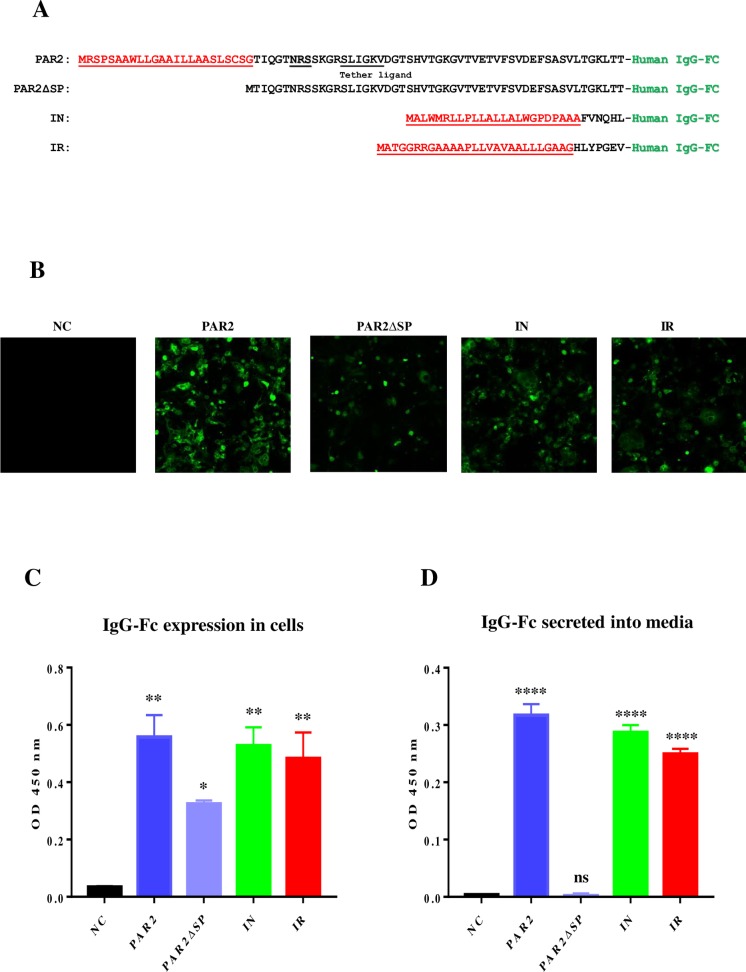
PAR2 signal peptide behaves like a classical signal peptide.A. Expression constructs for testing the role of the signal peptide of PAR2 in leading IgG-Fc secretion. The N-terminus of PAR2 with its signal peptide (PAR2), the N-terminus of PAR2 without the signal peptide (PAR2ΔSP), the N-terminus of insulin (IN), and the N-terminus of insulin receptor (IR) are fused to the human IgG-Fc fragment respectively. The signal peptide regions of PAR2, insulin, and insulin receptor are highlighted in red and underlined. Human IgG-Fc fragment is highlighted in green. B, C. Detection of IgG-Fc expression in cells by immuno-fluorescent staining and ELISA. COS7 cells expressing various IgG-Fc fusion proteins as indicated were fixed, penetrated using detergent, and then stained by FTIC-labeled fluorescent antibodies (B) or detected by ELISA (C). For ELISA, samples are performed in quadruplicates and the results are shown in mean ± sd. Statistical analysis (One-Way ANOVA) shows that, compared with the control, NC, PAR2 (** p = 0.0019), PAR2ΔSP (* p = 0.0249), IN (** p = 0.0024), and IR (** p = 0.0038). D. Detection of IgG-Fc secretion into media by ELISA. Serum free conditioned medium from COS7 cells expressing various IgG-Fc fusion proteins with different N-termini, including PAR2 N-terminus (PAR2), PAR2 N-terminus without the signal peptide (PAR2ΔSP), the N-terminus of insulin (IN), and the N-terminus of insulin receptor (IR). Untransfected cells were used as the negative control (NC). Samples are performed in quadruplicates and the results are shown in mean ± sd. Statistical analysis (One-Way ANOVA) shows that, compared with the control, NC, except PAR2ΔSP (ns, p = 0.9997), PAR2, IN, and IR all showed great amount of secreted IgG-Fc protein (**** p <0.0001), All experiments have been performed 3 times and very similar results have been observed. Example data is shown.